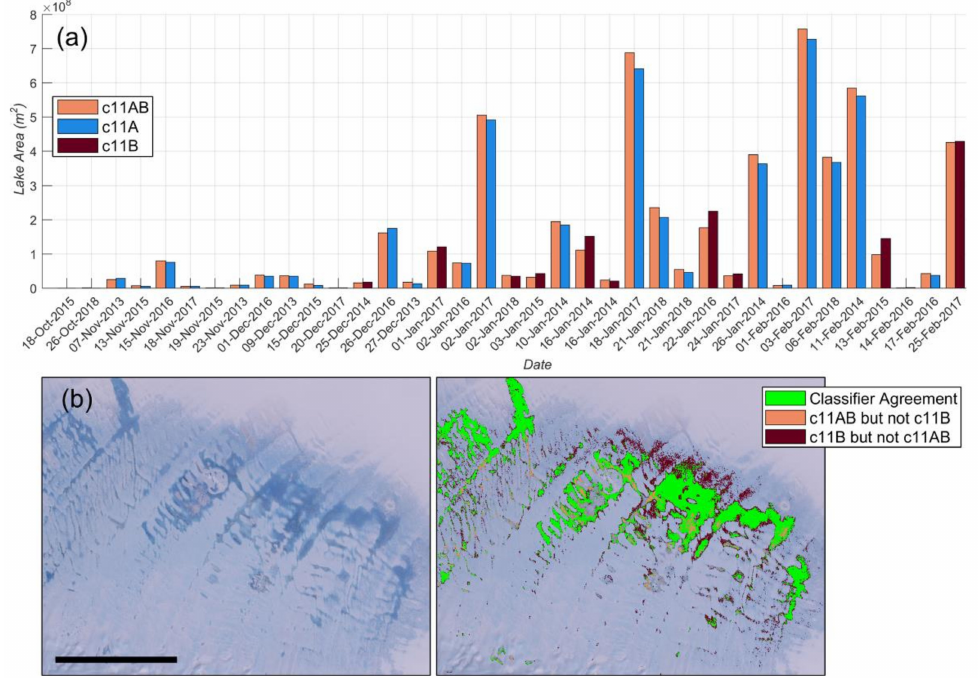
Figure 7. ( a ) Classified lake areas from c11A, c11B, and c11AB classifiers applied to both Amery Ice Shelf and Roi Baudouin Ice Shelf. Scenes were filtered to remove imagery with sun elevations less than 20 ◦ . ( b ) An example of classifier di ff erence is shown across shallow lakes on the Roi Baudouin Ice Shelf (scene LC08_L1GT_153109_20160303).